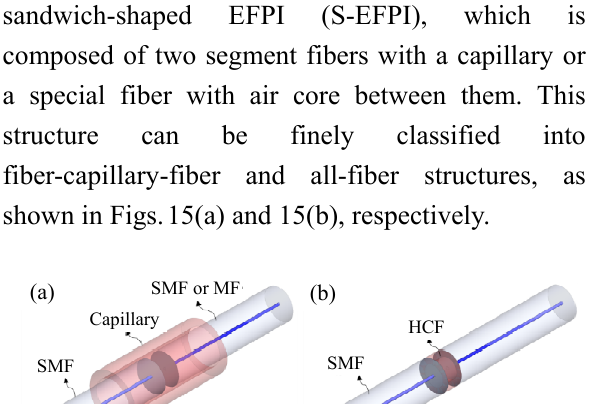
Fig. 14 Schematic diagram of tip-type IFPI formed by splicing an SMF and a PCF.